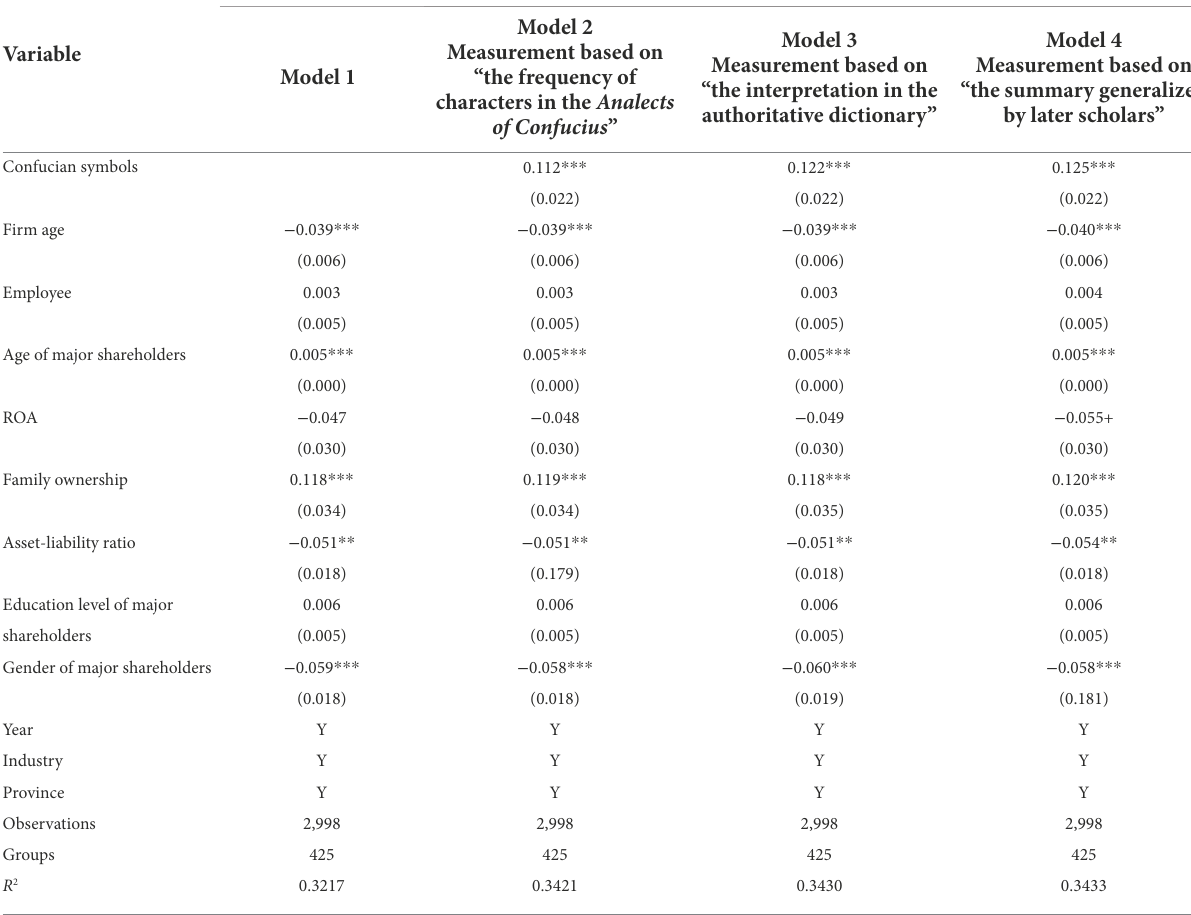
TABLE 8 Results of using institutional investor shareholding to measure external supervision